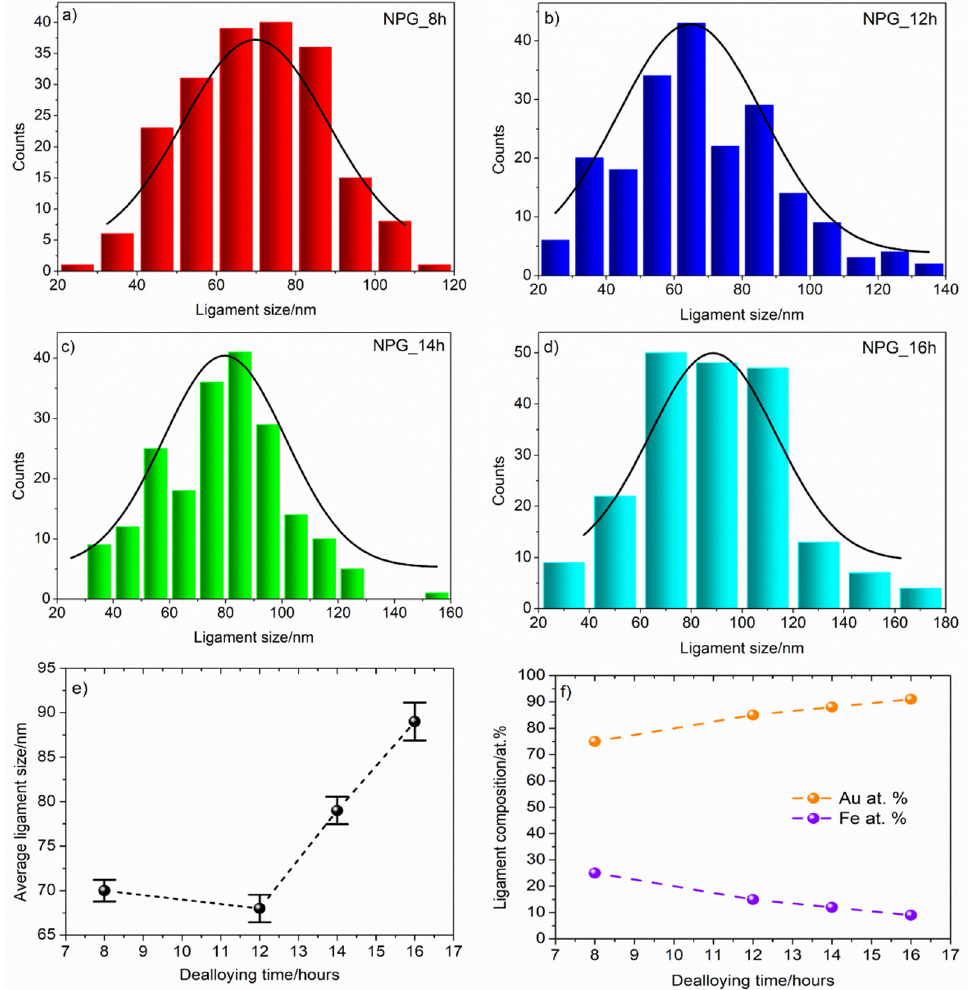
Figure 4. Statistical and compositional analyses of ligaments: histograms and distributions for the samples ( a ) NPG_8h, ( b ) NPG_12h, ( c ) NPG_14h, and ( d ) NPG_16h. ( e ) Average ligament size within standard error as a function of dealloying time. ( f ) EDS analysis of ligaments; the dashed lines have to be intended as a guide for the eyes.